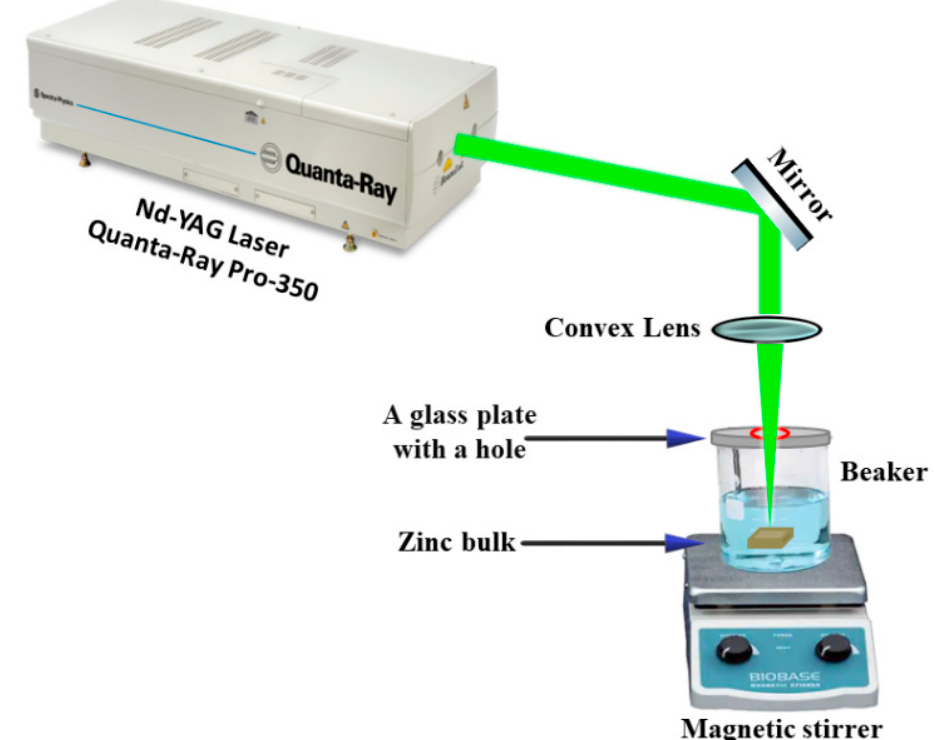
Figure 1. Experimental setup of laser ablation for preparing ZnONPs colloids using 532 nm pulsed Nd: YAG laser.